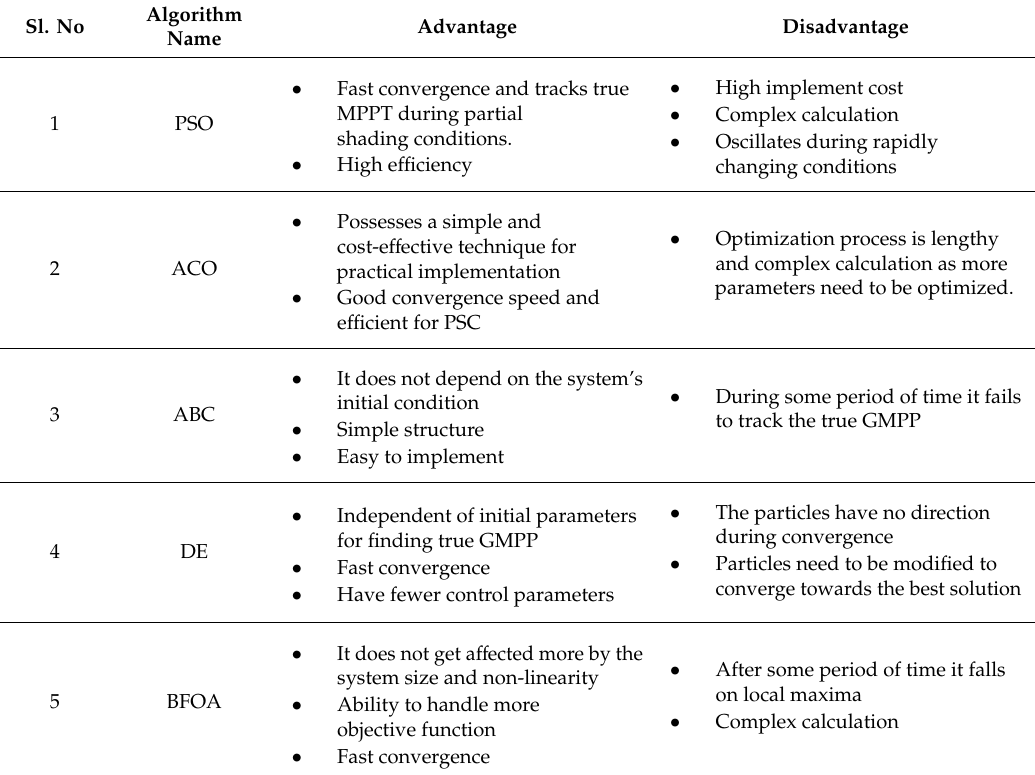
Table 1. Advantages and disadvantages of reported algorithms.